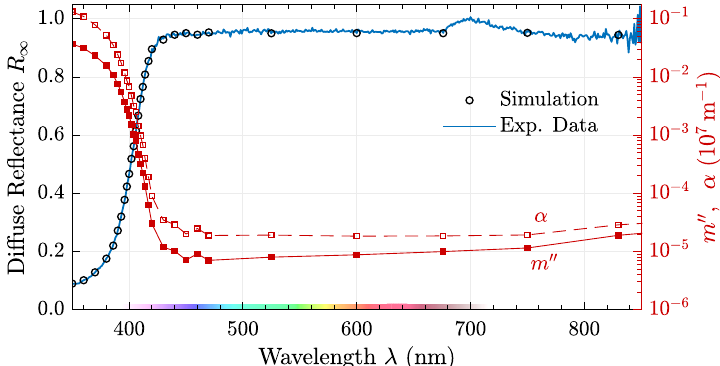
Figure 18. Monte Carlo ray tracing simulation results (circles) for a rutile powder sample (experimental data: solid blue line) and calculated imaginary refractive indexes m (cid:48)(cid:48) (filled squares, red, solid line) and absorption coefficient α (open squares, red, dashed